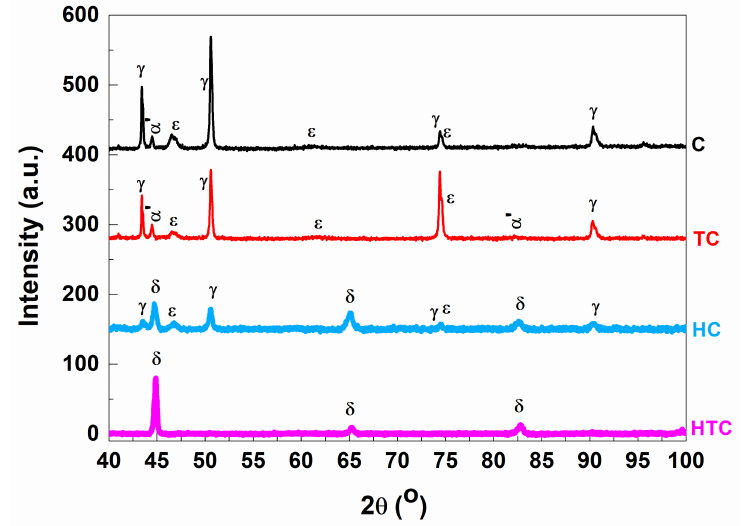
Figure 5. XRD patterns showing phase composition of C and TC alloys, and their evolution after the in situ heat treatment at 975 K.